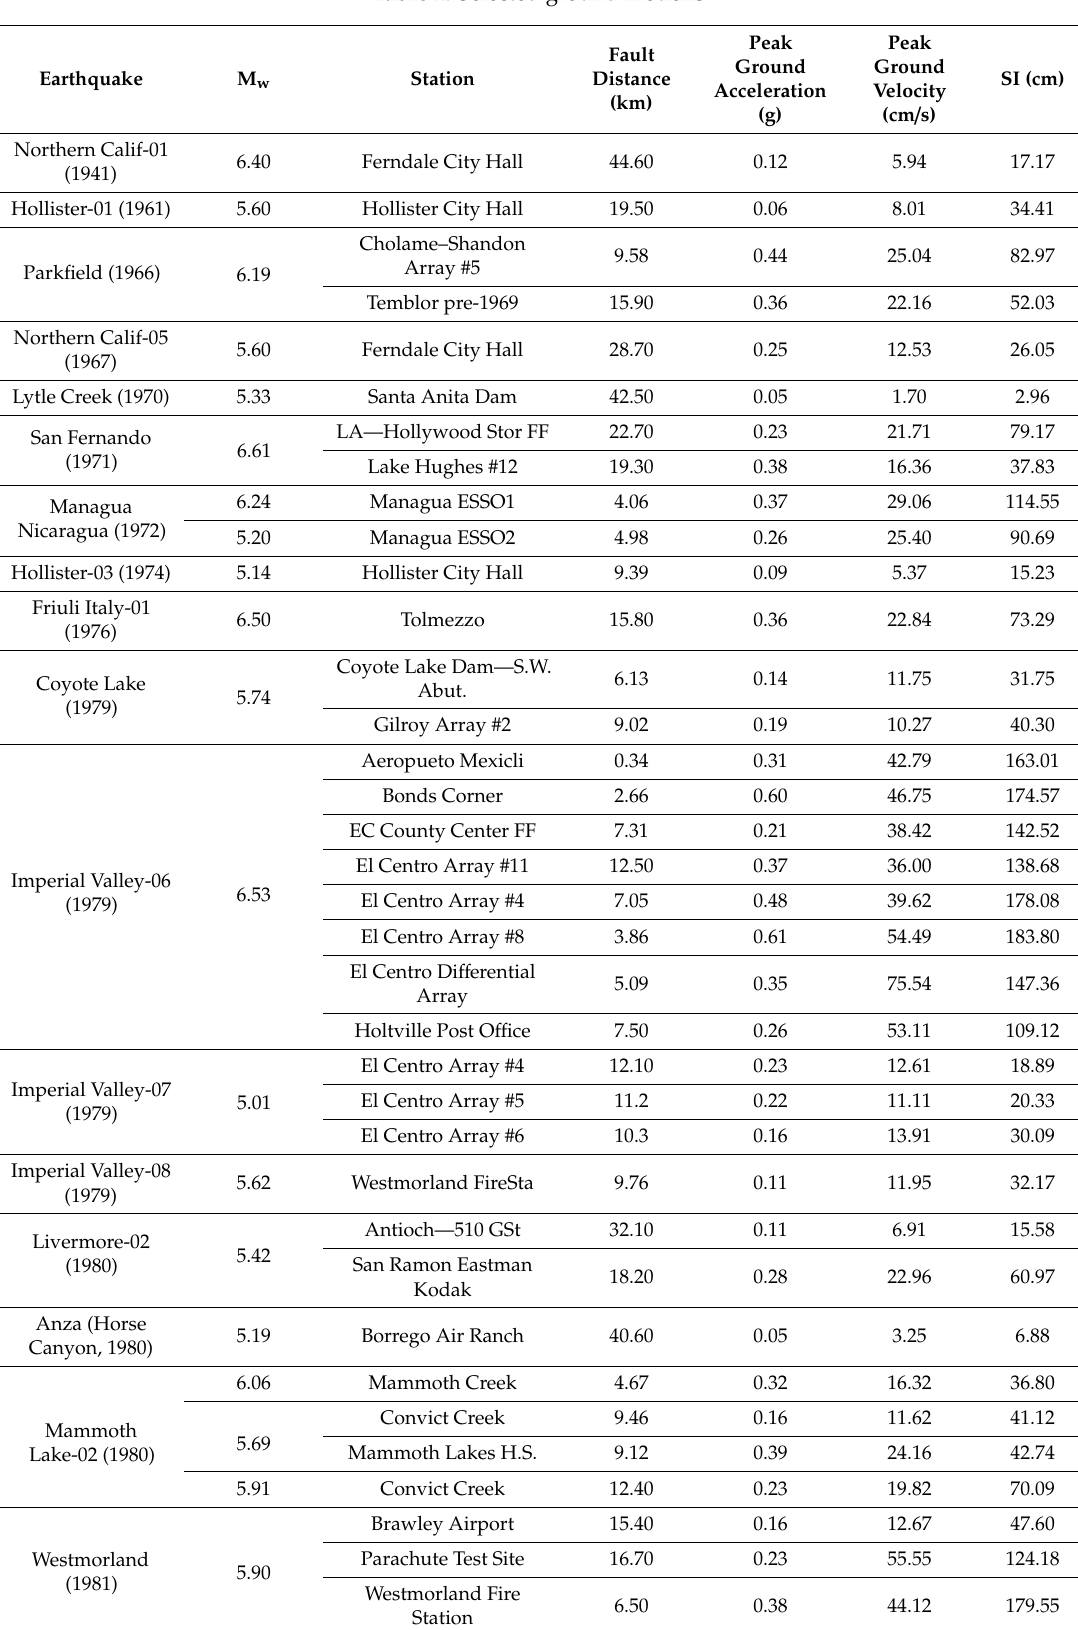
Table 2. Selected ground